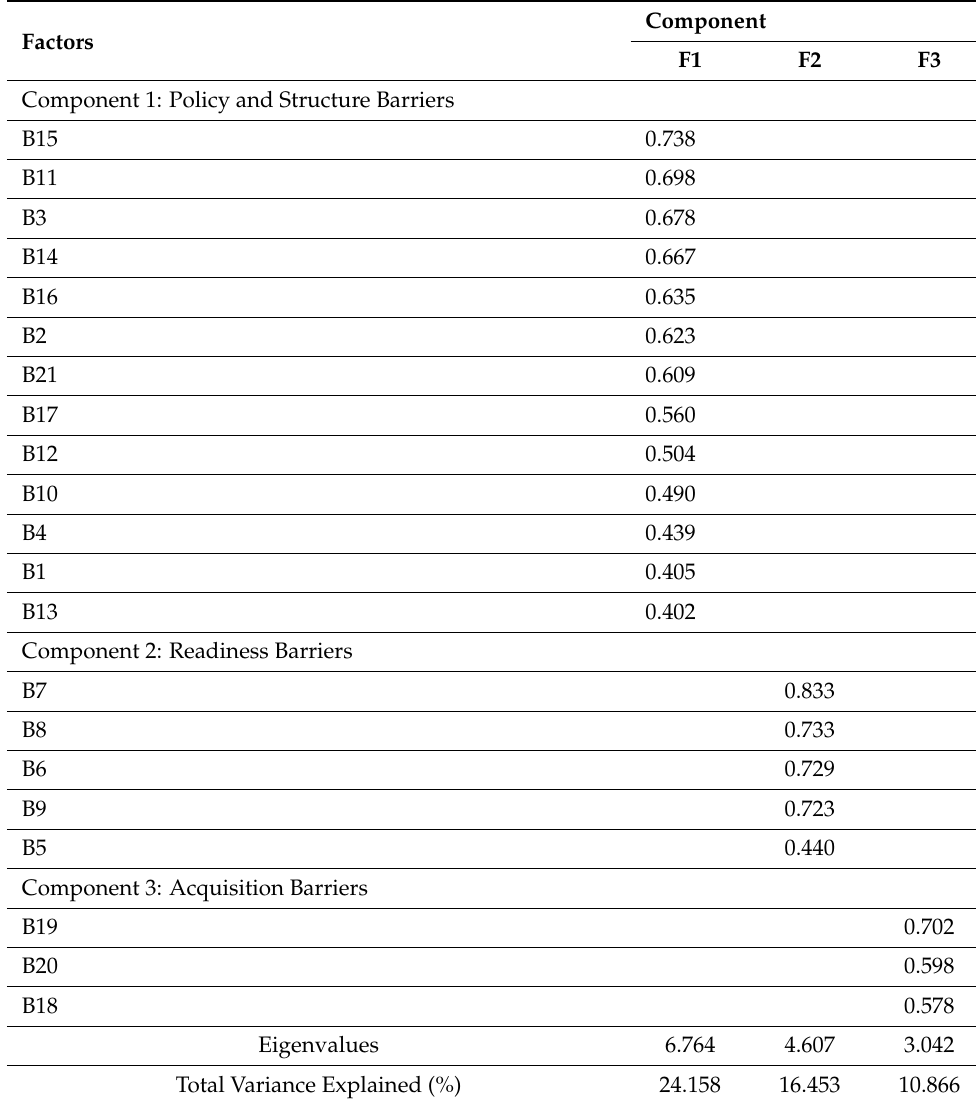
Table 3. Rotated Component Matrix of the 4IR Innovations Adoption